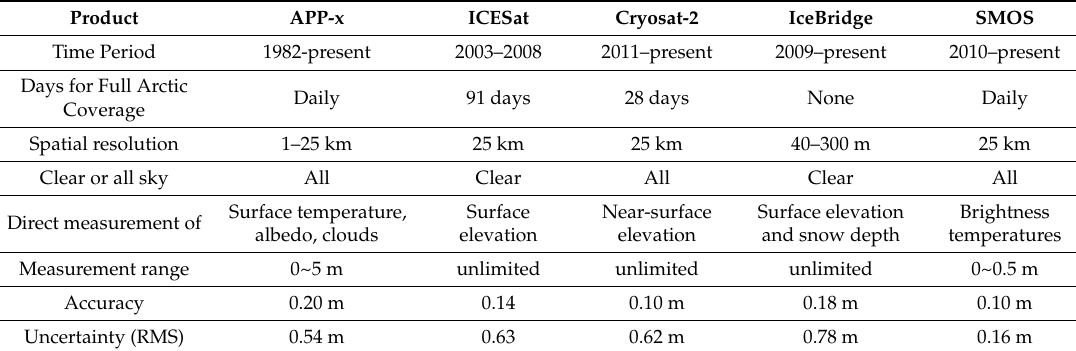
Table 1. Characteristics of each satellite or aircraft ice thickness